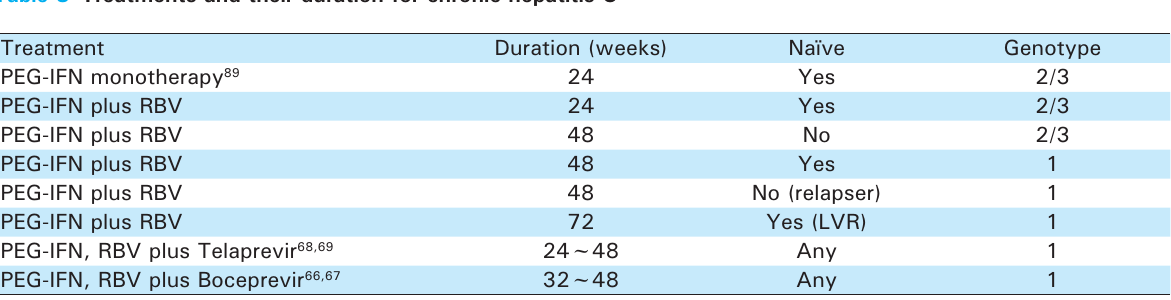
Kanda et al. Pegylated interferon-alfa plus ribavirin therapies for chronic hepatitis Table 3 Treatments and their duration for chronic hepatitis C Treatment Duration (weeks) Naïve Genotype PEG-IFN monotherapy 89 24